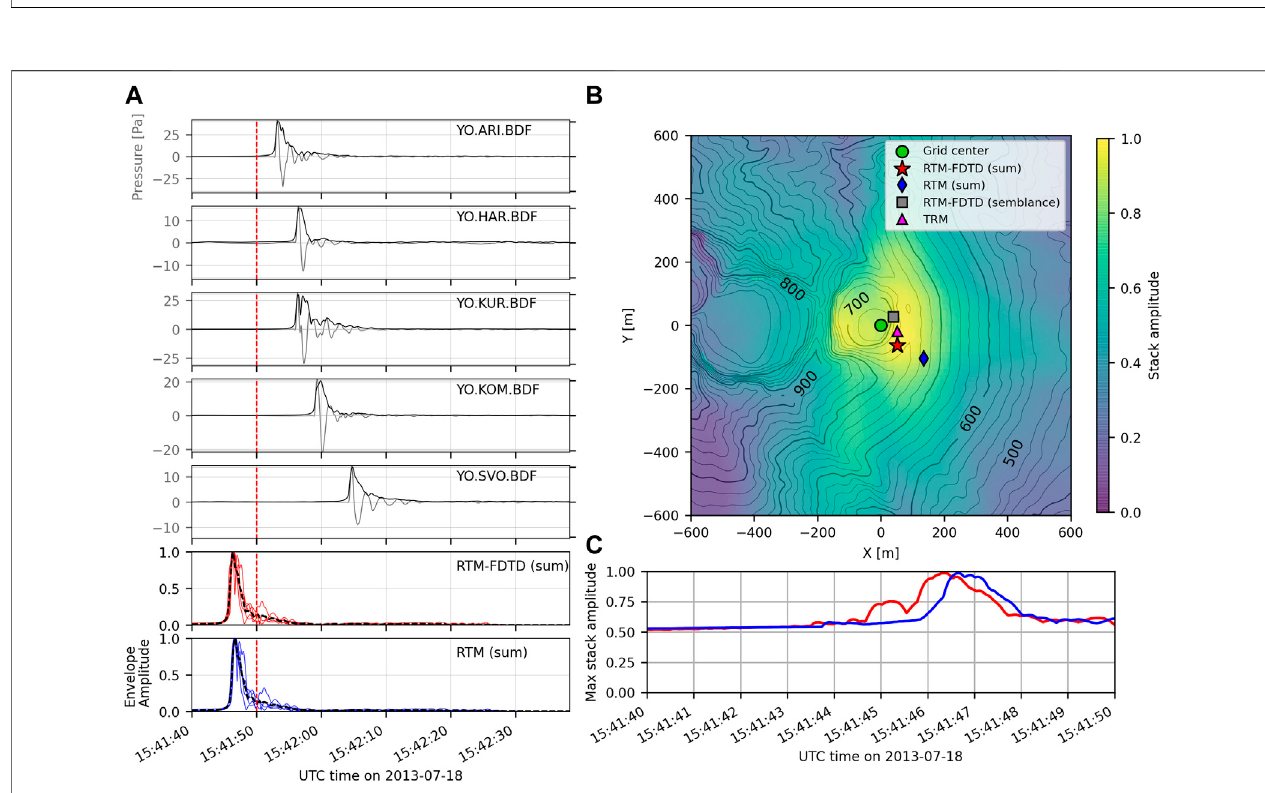
FIGURE 7 | Sakurajima explosion waveforms and location comparison. Figure layout is the same as Figure 3 , except waveforms are fi ltered between 0.05 and 3 Hz. The TRM result of Kim and Lees (2015) is shown as a magenta triangle. RTM-FDTD and TRM sources estimates are consistent, while RTM locates the source further to the